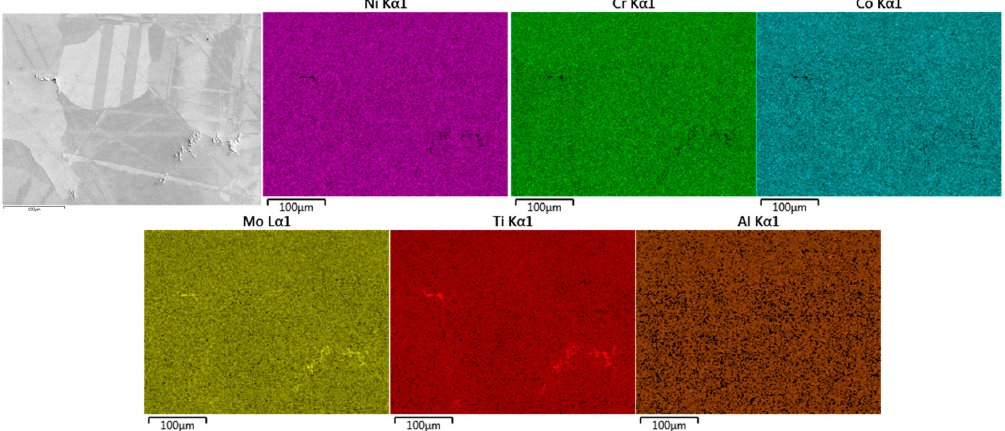
Figure 8. EDS analysis of cast C263 microstructure.